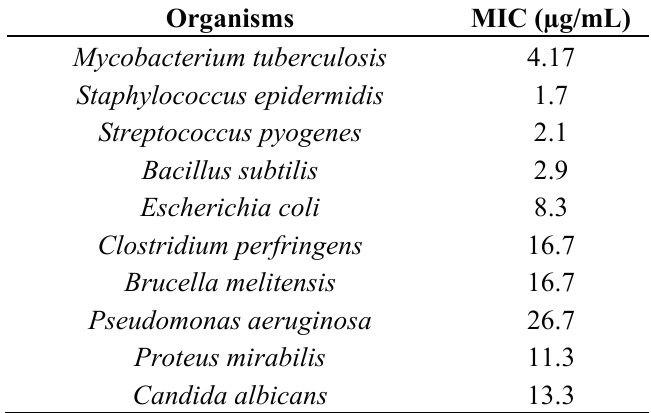
Table 3. Antimicrobial activity of the purified antimicrobial agent, treponemycin, produced by Streptomyces isolate